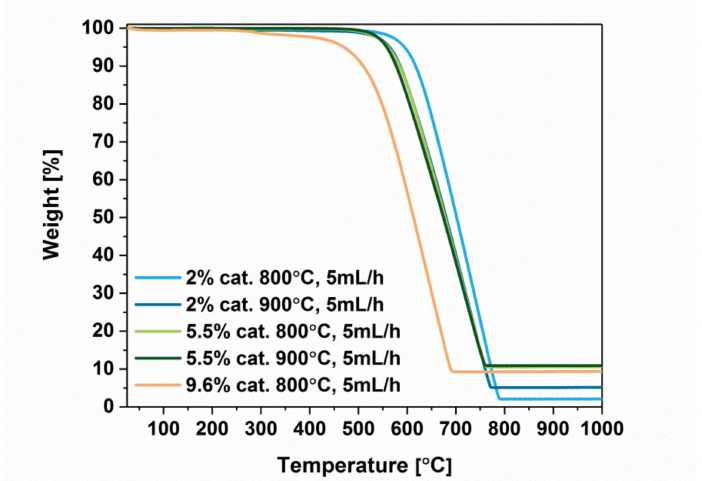
Figure 6. Comparison of thermograms of MWCNTs obtained at 800 ◦ C or 900 ◦ C with di ff erent amounts of catalyst employed (2%, 5.5%, and